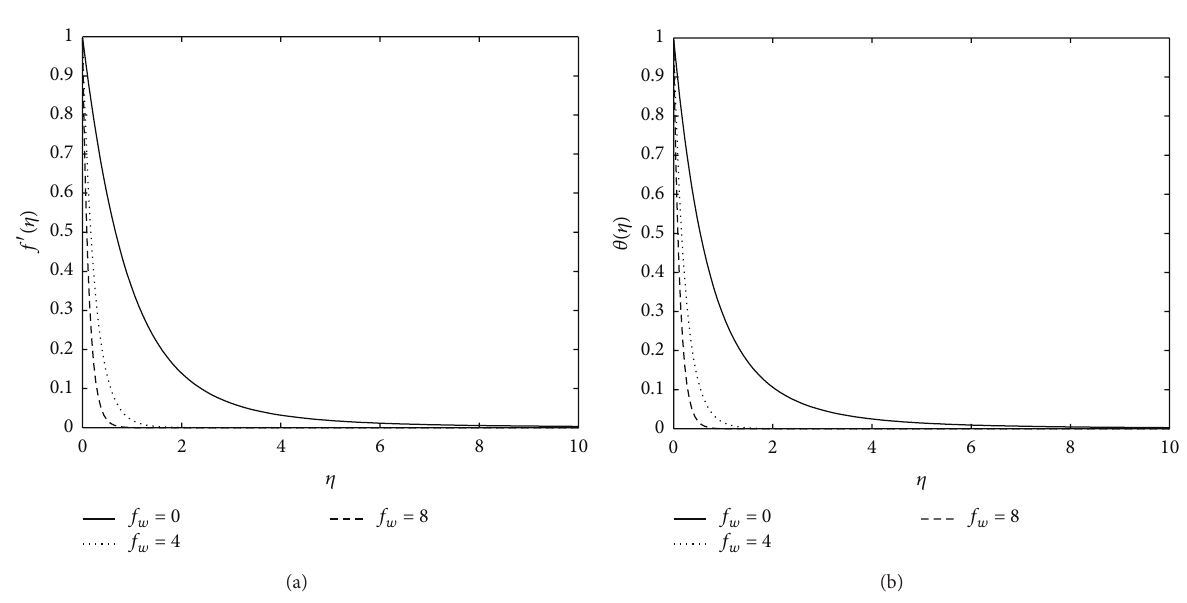
Figure 5: Effect of 𝐴 on the velocity and temperature profiles.